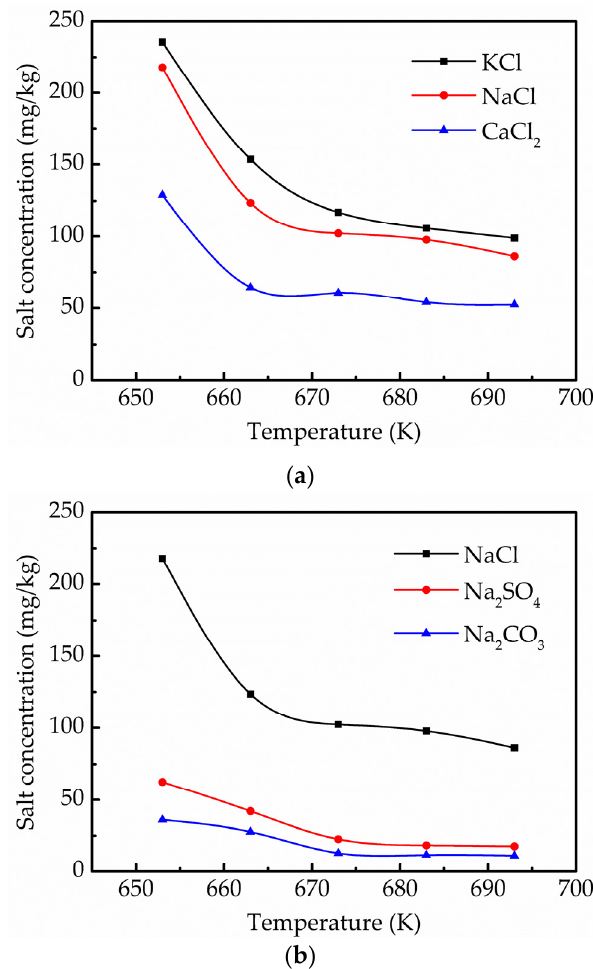
Figure 5. Relationship between salt concentration and temperature at different supercritical states: ( a ) Cl − salt of Na + , K + , Ca 2+ , ( b ) Na + salt of Cl − , CO 32 − , SO 42 − .